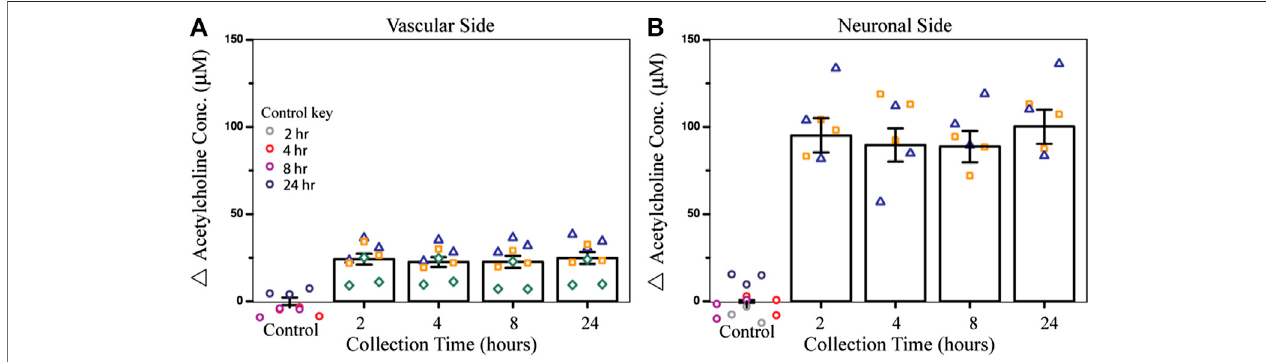
FIGURE 2 | Effect of CPF on acetylcholine metabolism within the NVU as determined from the electrochemical assay. (A) Bar graph indicating the change in acetylcholine concentration from control (DMSO) in vascular side eluate over time (2, 4, 8, or 24 h treatment), showing elevated acetylcholine levels (24 ± 3 µM) after 2 h of CPF treatment (10 µM CPF, p -value < 0.003). (B) Bar graph indicating a change in acetylcholine concentration in neuronal side eluate over time showing elevated acetylcholine (95 ± 10 µM)2 h after CPFwasadministered tothe vascularside,asigni fi cantincrease from thecontrol( p -value < 0.04).Dataarerepresentedasthe means and standard errors, symbols represent technical replicates, n (cid:2) 6 – 9 for samples, and n (cid:2) 9 – 12 for controls. Control samples were collected over 24 h and their respective collection time is indicated in the control